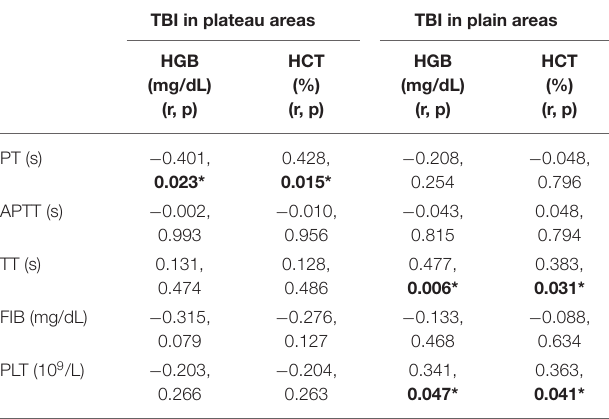
TABLE 4 | Correlation between coagulation parameters and red blood cells (RBCs) indexes in patients with TBI. TBI in plateau areas TBI in plain areas